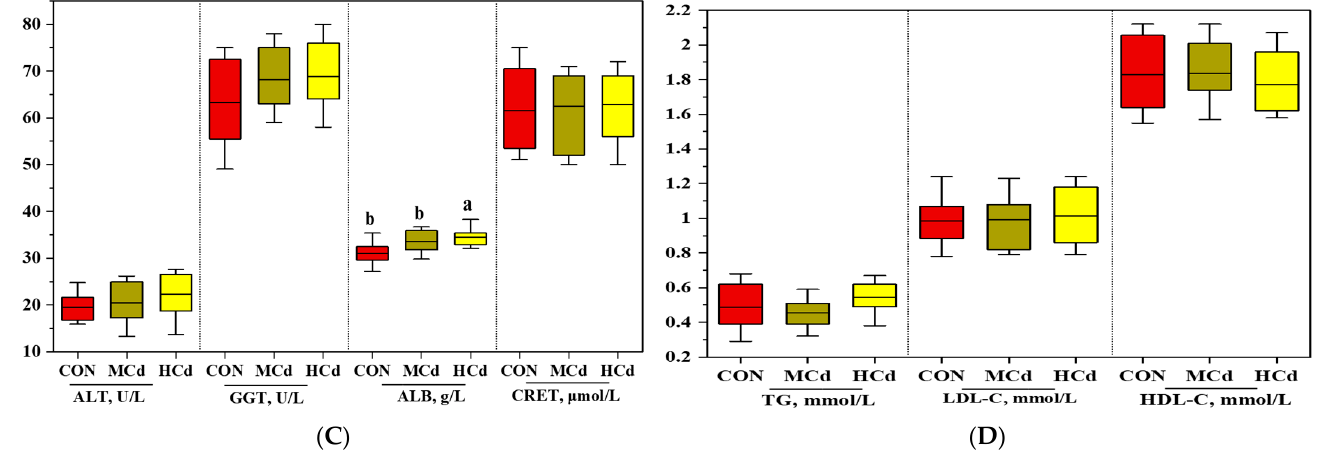
Figure 2. Effects of dietary cadmium levels on blood biochemical indices ( A – D ) of goats. The values are expressed as the mean ± SEM. One-way ANOVA was used, followed by post hoc Tukey’s test. Different letters (a, b) indicate significant difference a significant difference among the three dietary treatments at p < 0.05. ALT: alanine aminotransferase; AST: aspartate aminotransferase; GGT: gamma-glutamyl transferase; ALP: alkaline phosphatase; LDH: lactate dehydrogenase; ALB: albumin; CRET: creatinine; TC: total cholesterol; TG: triglyceride; LDLC: low-density lipoprotein cholesterol; HDLC: high-density lipoprotein cholesterol; BUN: blood urea nitrogen; GLC: glucose. Treatment: CON, MCd, HCd: 0.23, 0.63, and 1.07 mg of Cd/kg of diet DM, respectively.